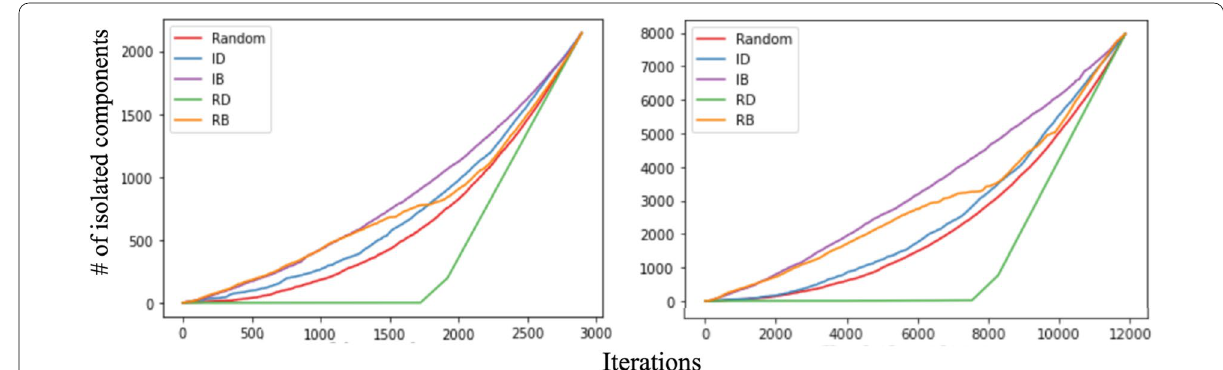
Fig. 15 Evolution of Isolated components along edge extraction strategies for CARRIS (left) and for the multilayer network